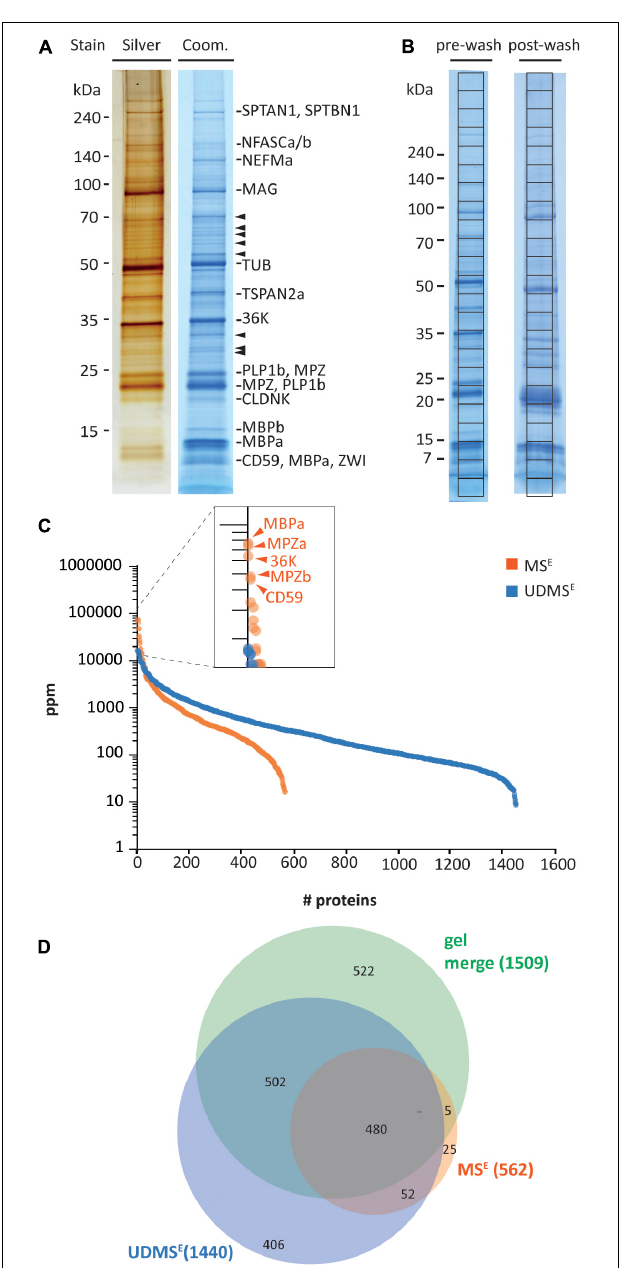
FIGURE 1 | Proteome analysis of zebrafish myelin. (A) One-dimensional separation of myelin biochemically purified from brains and optic nerves of adult zebrafish. Myelin was separated by 1D SDS-PAGE on Tris-glycine gradient gels, and proteins were visualized by silver staining (0.5 µ g load) or colloidal Coomassie (CBB250; 5 µ g load). Bands are annotated that mainly comprise known myelin proteins according to mass spectrometric identification. Arrowheads indicate bands in which no known myelin proteins were identified. (B) Myelin separated on Tris-glycine gradient gels (5 µ g load) before (pre-wash) or after (post-wash) an additional step of high-pH and high-salt conditions. The indicated grid divides each CBB250-stained lane into equally sized slices, which were excised for automated tryptic digest and LC-MS analysis, thereby, respectively, identifying 890 (pre-wash) and 1274 (post-wash) proteins ( Supplementary Table 1 ). (C) Number and relative